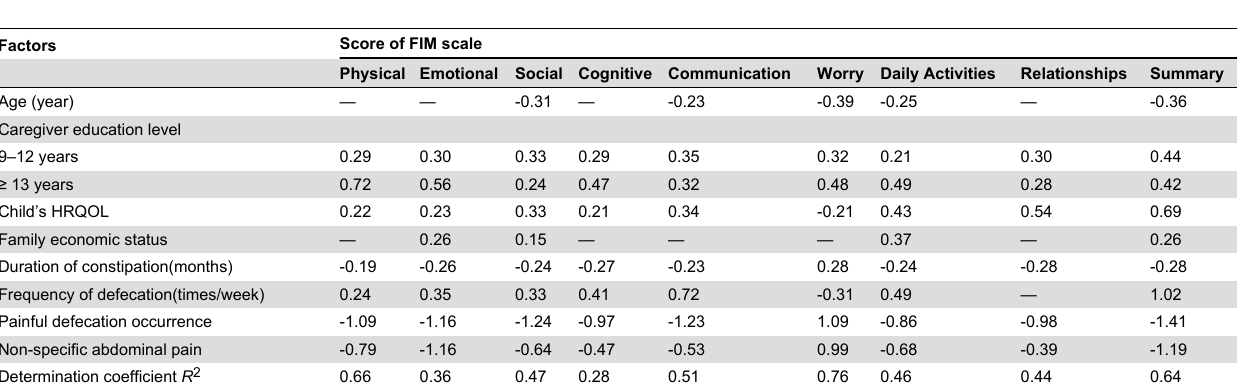
Table 6. Factors influencing caregivers HRQOL and family function of children with FC.